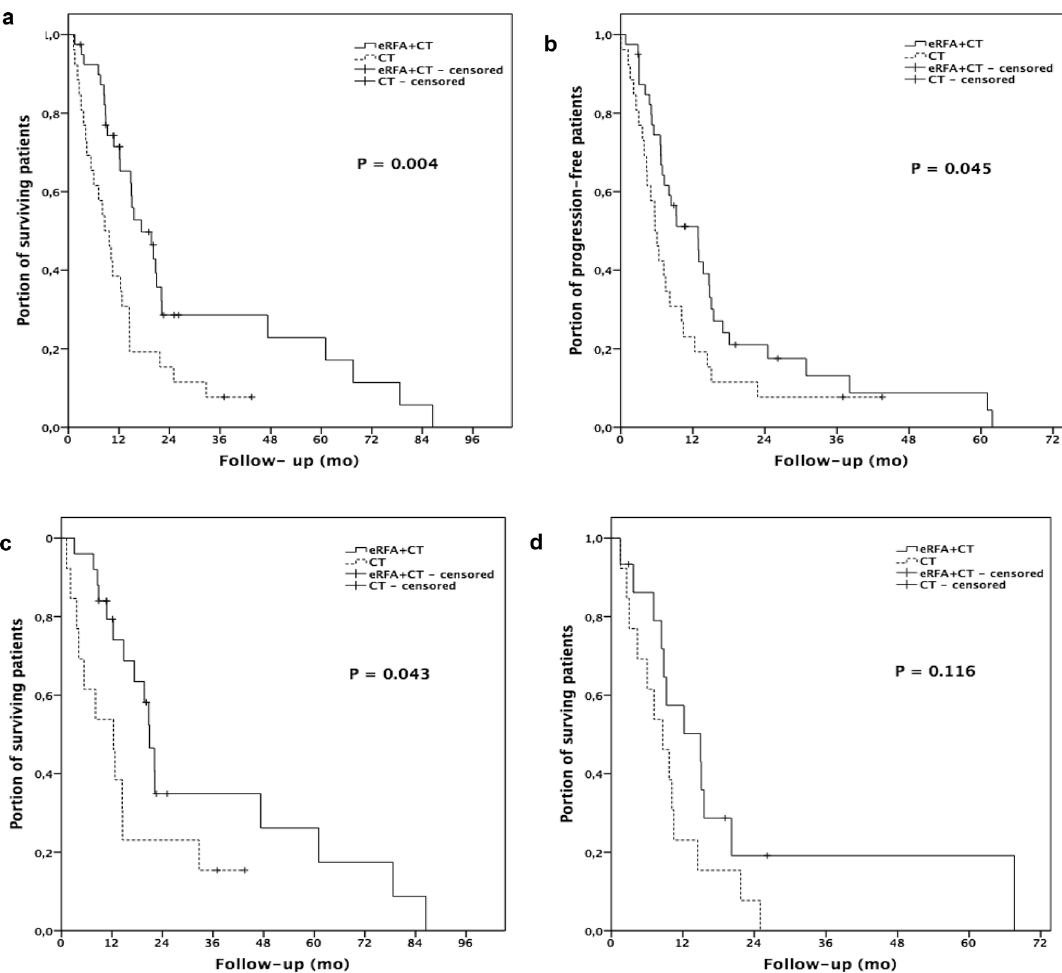
Figure 2. Kaplan–Meier survival analysis, with Log-Rank P. ( a ) Overall survival: eRFA + CT vs. CT alone. ( b ) Progression free survival: eRFA + CT vs. CT alone. ( c ) Overall survival of patients with non-metastatic disease: eRFA + CT vs. CT alone. ( d ) Overall survival of patients with metastatic disease: eRFA + CT vs. CT alone. CT chemotherapy, eRFA endobiliary radiofrequency